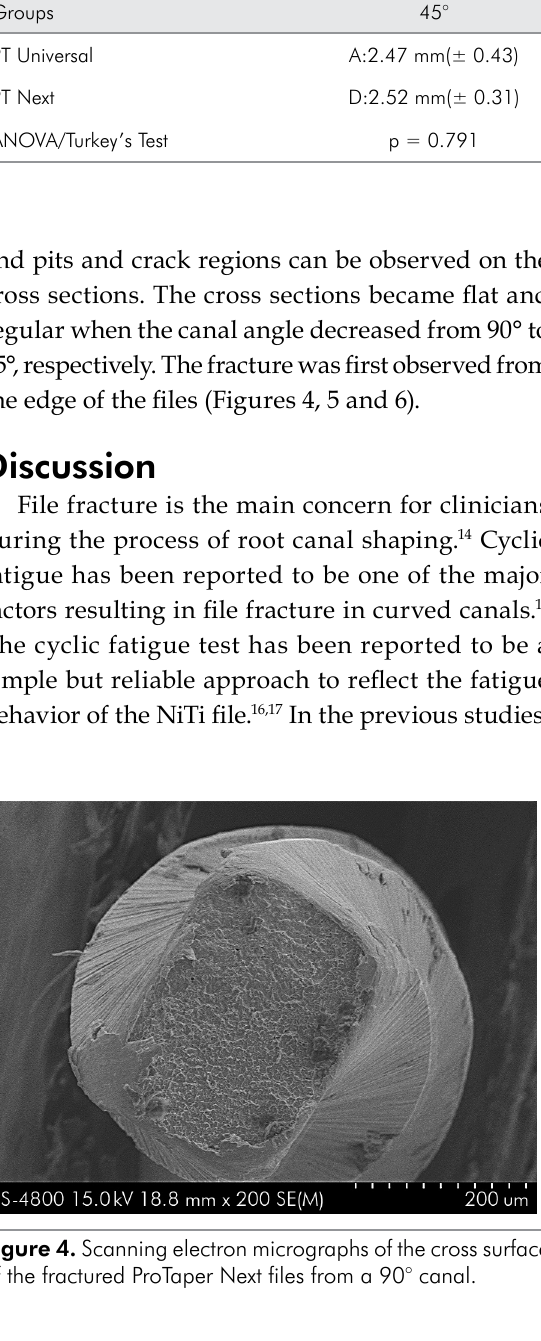
Table 2. Mean (± SD) of the fractured fragments of different groups (n = 10).